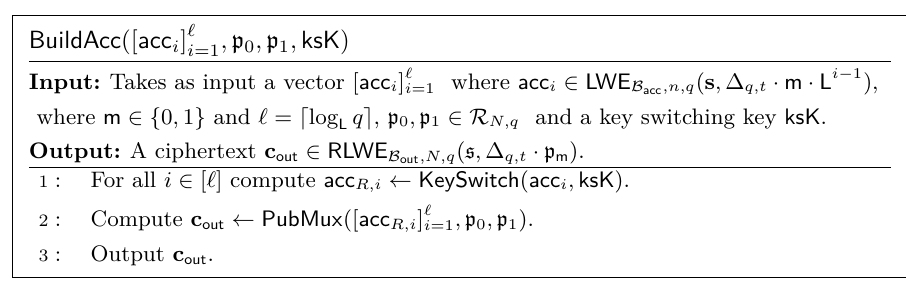
Figure 2: Accumulator builder